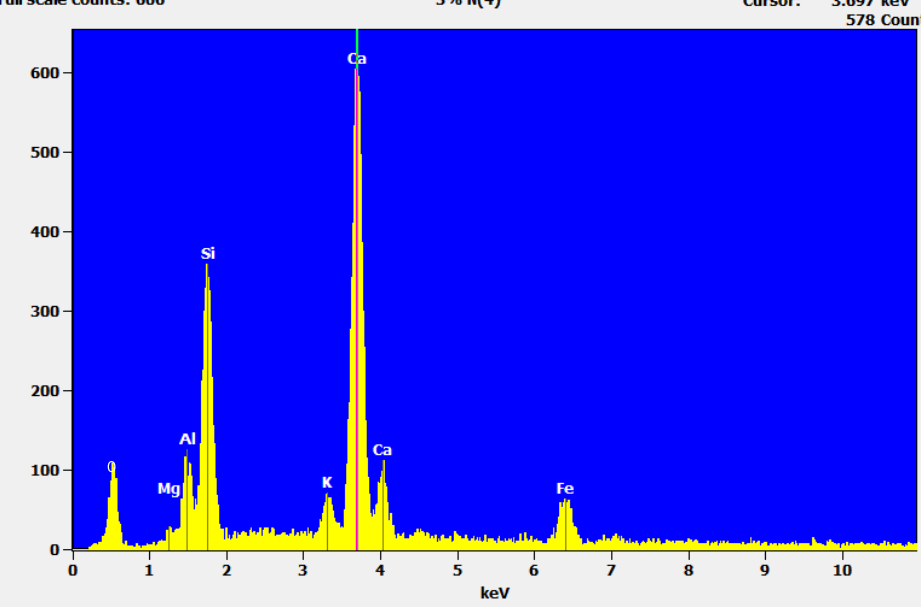
Figure 14. EDS spectrum of TQ3 at 28 d.